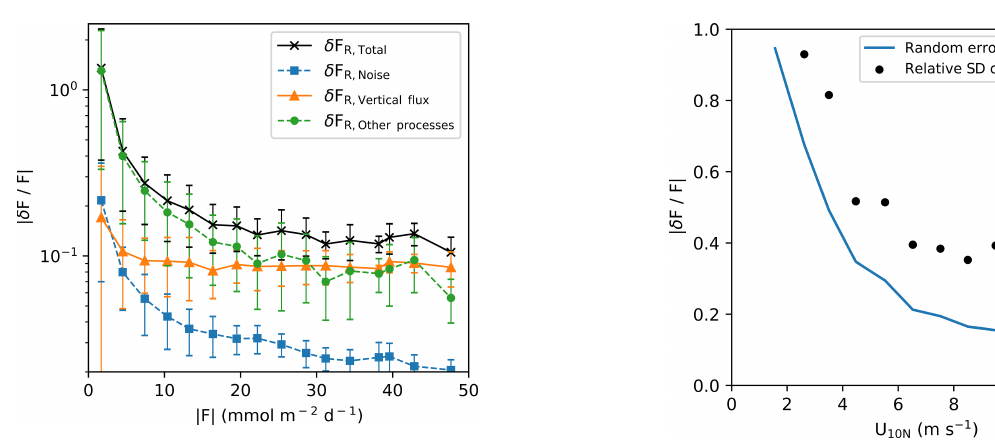
Figure 6. Comparison of relative random uncertainty in hourly CO 2 flux and relative standard deviation (RSTD; standard deviation / | flux mean | ) of the EC CO 2 flux from two Arc- tic cruises. These results are binned in 1ms − 1 wind speed bins. flux from this region was 0.5 mmolm − 2 d − 1 , which is